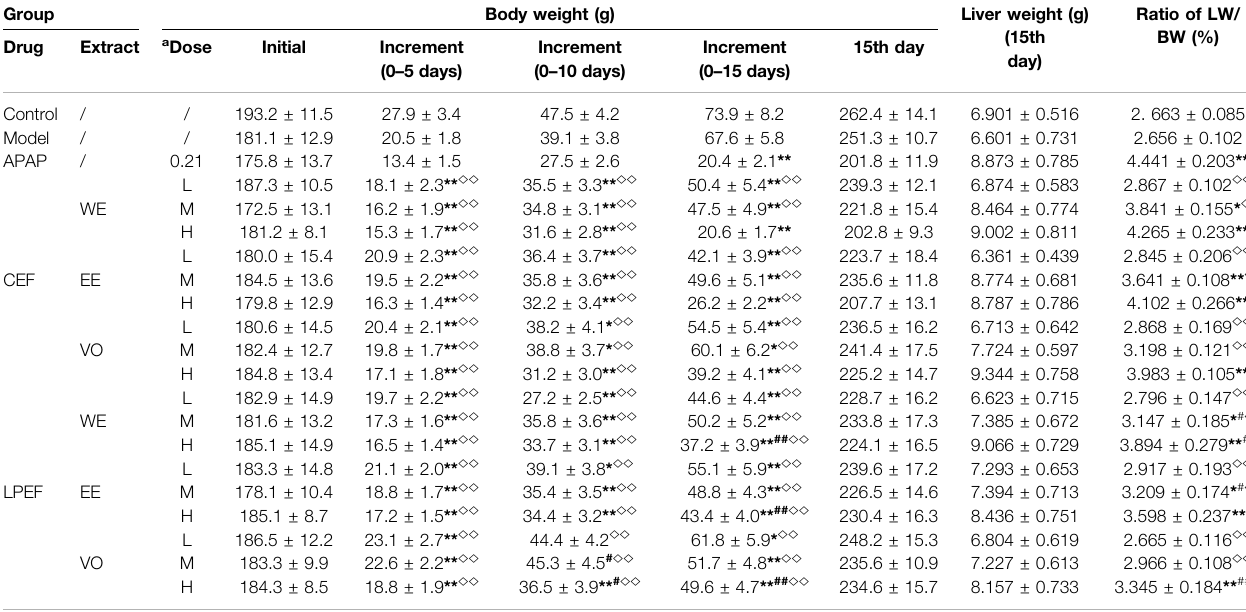
TABLE 4 | Comparison of body weight (BW), liver weight (LW), and liver-to-body weight ratio among different groups.